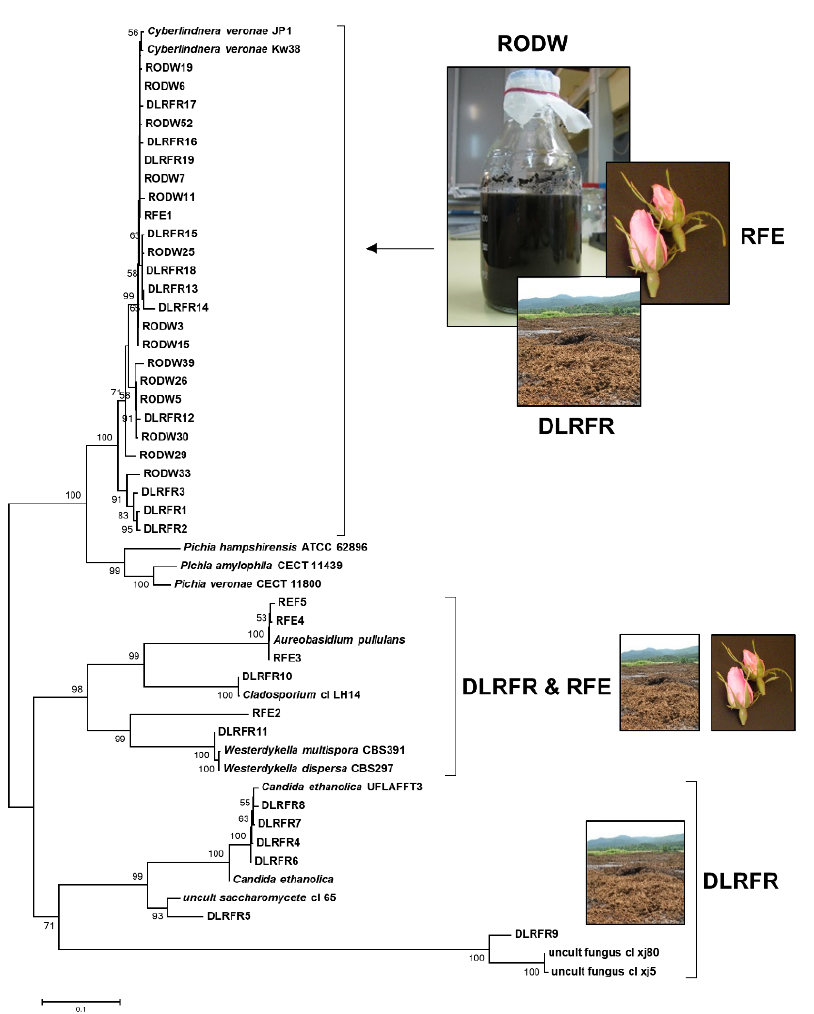
Figure 1. Molecular characterization of yeast and mold diversity. A neighbor-joining phylogenetic tree constructed from ITS sequences of RODW, DLRFR and RFE isolates and BLAST search identified sequences showing high level of homology. The percentage of replicate trees in which the associated taxa clustered together in the bootstrap test are shown next to the branches.